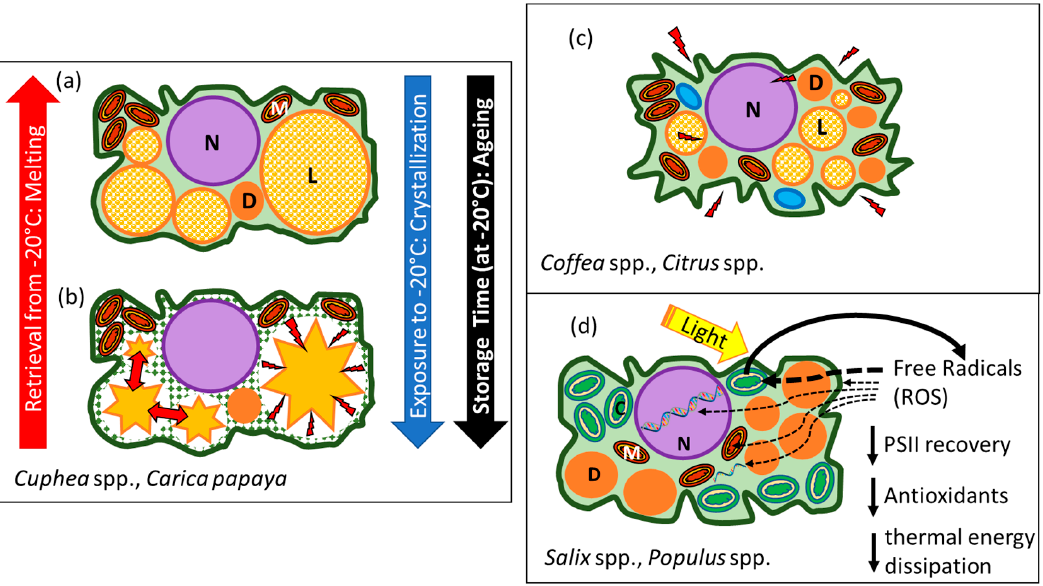
Figure 3. Schematic diagram of the hypothetical dry architecture of ‘intermediate’ seed storage behaviour. ( a ) Cells that survived drying may be damaged in the freezer when ( b ) storage lipids crystallise and leave large gaps in the glassy matrix and increase the potential for oxidative damage or structural collapse. ( c ) Cells that survive sufficient drying to approach cytoplasmic solidification, but die with further drying (represented by some species of coffee or citrus and neem). ( d ) Germplasm presenting increased longevity with decreased storage moisture and temperature, according to models, but having an extremely rapid basal deterioration rate (represented by Salix seeds, chlorophyllous fern spores and pollen of many species). Potentially these cells lack protection from oxidative stress, which may be harsher when the light-harvesting photosynthetic apparatus is present. Red arrows and lighting symbols represent areas of physicochemical stress due to drying or lipid crystallisation. C, chloroplasts; N, nucleus; L, lipid body; M, mitochondria; D, other storage reserves such as plastids filled with starch or protein bodies, or complexes formed by LEA and HSP and raffinose or other oligosaccharides (adapted from [22], used with permission from Cambridge Press).